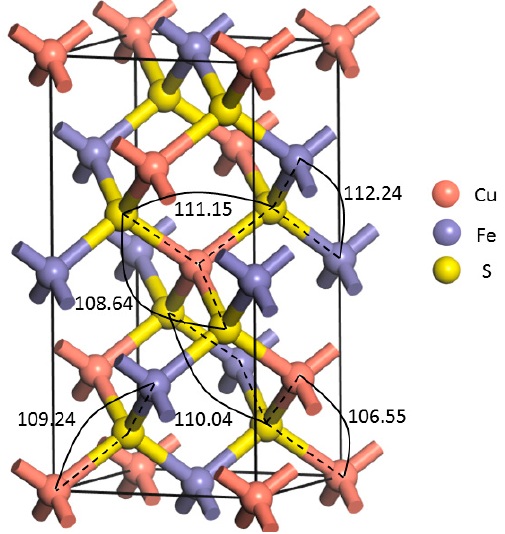
Figure 1. The optimized unit of chalcopyrite.